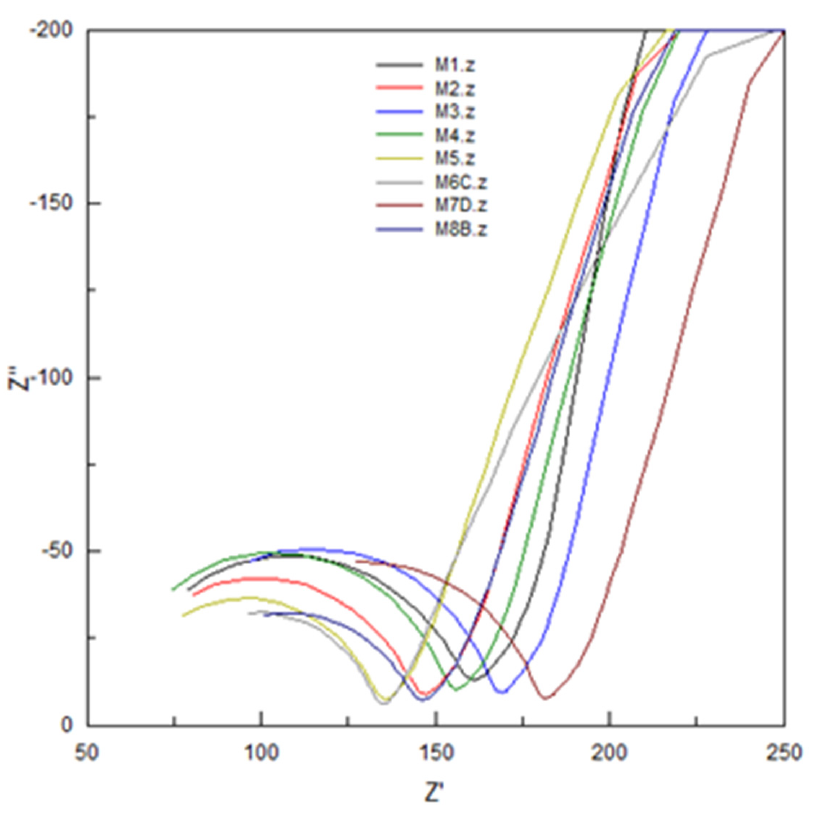
Figure 9. Nyquist plot for EIS characterizations of PIMs, the composition of which is specified in Table